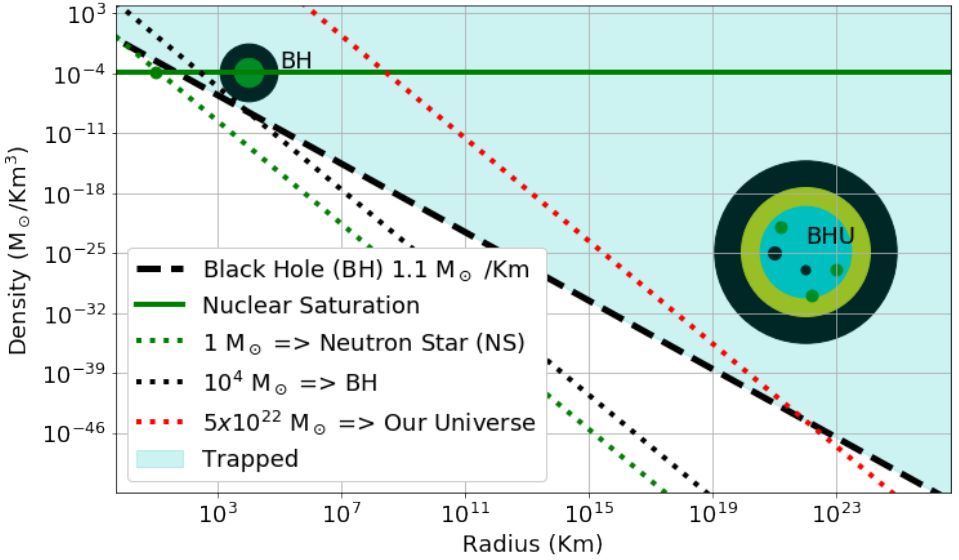
Figure 2. This is similar to Figure 1 but extending the scale to include a cloud of mass M = 5 × 10 22 M (cid:12) (red dotted line) which corresponds to the size of our